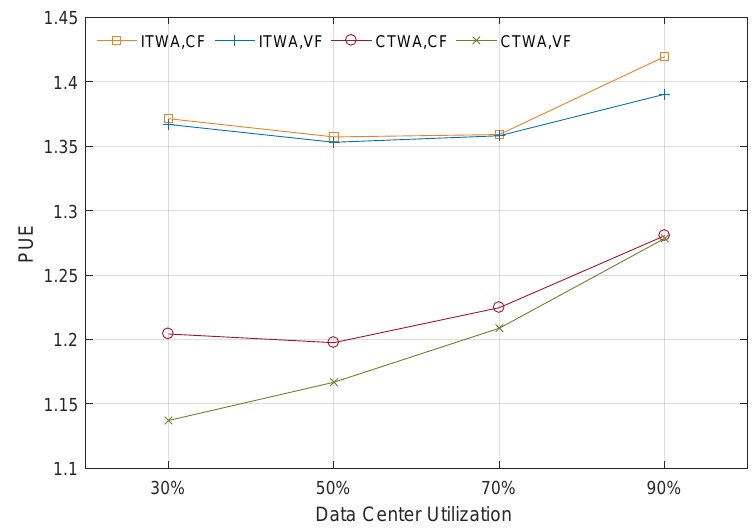
Figure 14. Power Usage Effectiveness for case